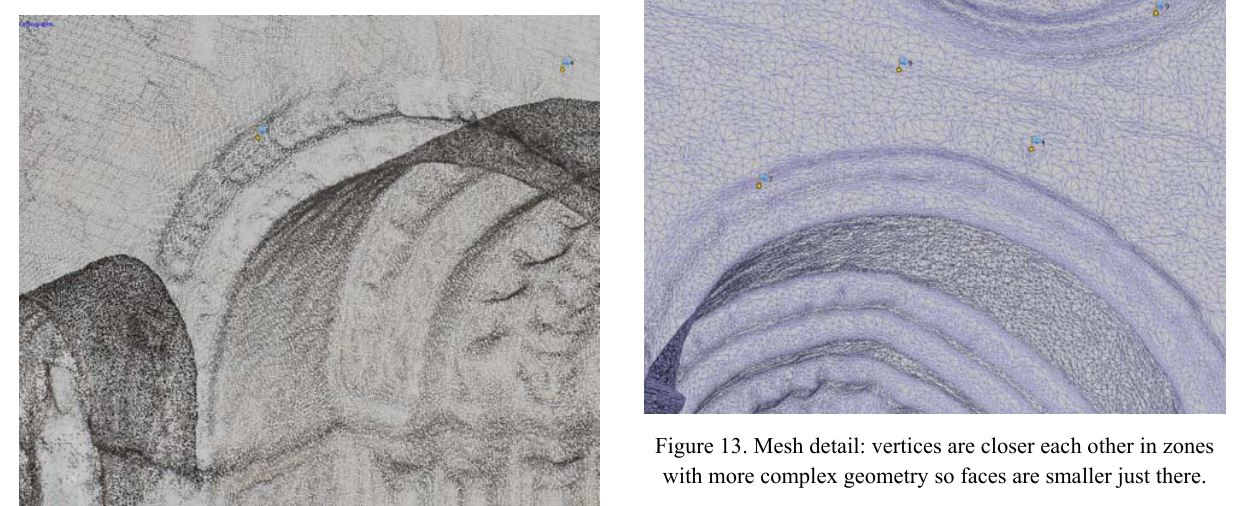
Next step was to triangulate the dense cloud points to get the Mesh. Which is needed to obtain faces, namely, the DSM